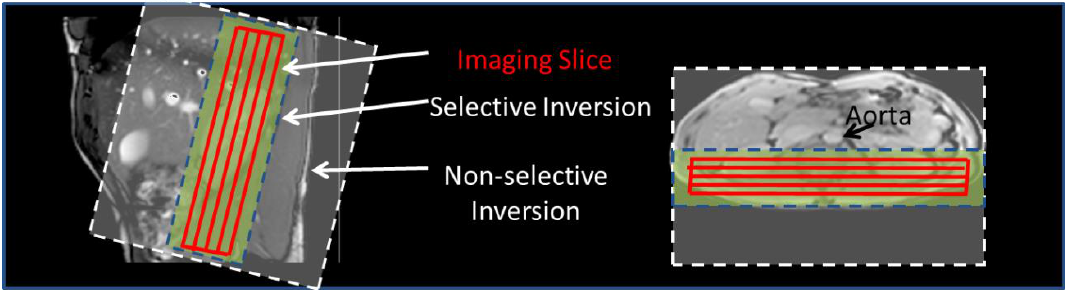
Figure 1. Flow-sensitive alternating inversion recovery (FAIR) scheme. Positioning of the selective and non-selective labeling slabs shown relative to the imaging volume of the kidneys and the aorta.